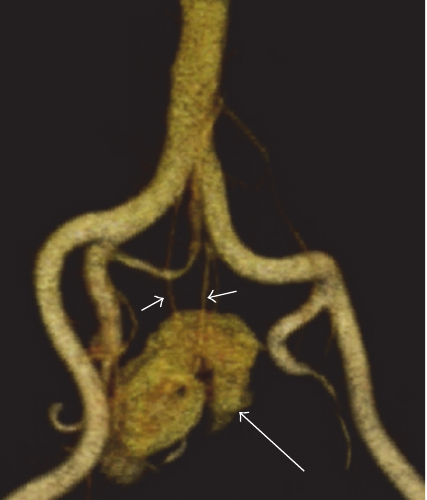
Figure 4: Pelvic kidney. 3D volume-rendered MRA image shows a pelvic kidney (long arrow) positioned in the midline below the aortic bifurcation. Note the variant vascular supply, including multiple anomalous accessory renal arteries (short arrows) arising from the common iliac